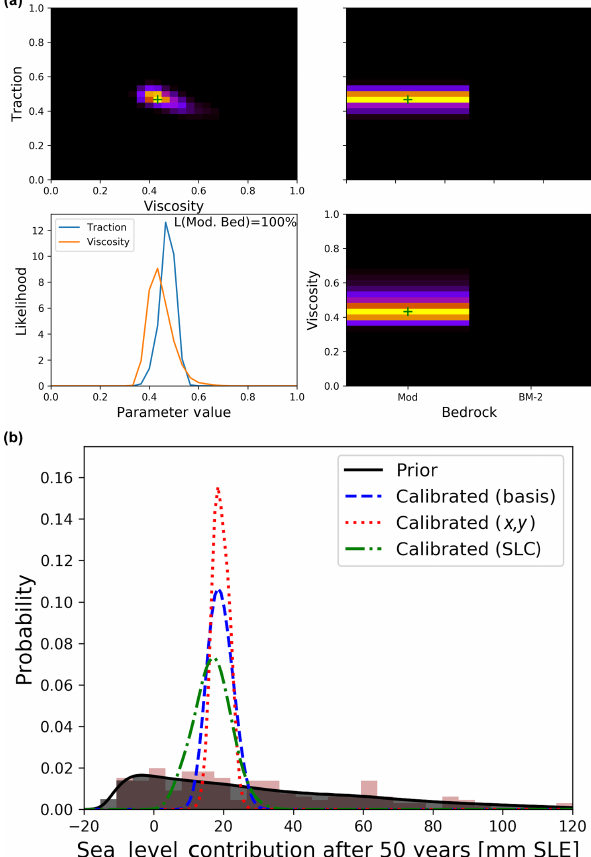
Figure 6. (a) Likelihood of parameter combinations in basis repre- sentation from satellite observations (evaluations of Eq. 12). Upper right panels show likelihood values marginalised to pairs of param- eters, normalised to the respective maximum for clarity. Lower left panel shows likelihood values marginalised to individual parame- ters for the two scalar parameters (line plots) and bedrock topogra- phy map (text and quotation within), normalised to an integral of one in the style of probability density functions. Values of the set of parameters with highest likelihood are shown by green crosses. (b) Projected sea level rise contributions at the end of model pe- riod for uncalibrated BISICLES runs (brown shades), uncalibrated emulator calls (grey shade) and different calibration approaches (coloured